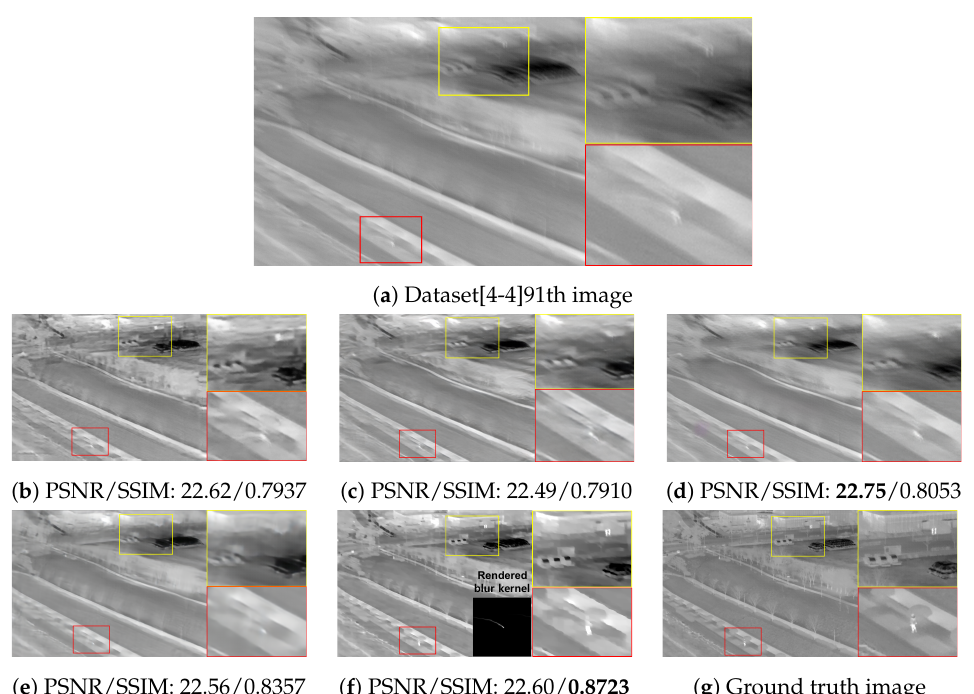
Figure 14. Qualitative comparison of deblurring results on the SBTI dataset [4-4]91th. ( a ) Synthetic blurry thermal image, ( b ) SRN [33], ( c ) SIUN [36], ( d ) DeblurGAN.v2 [35], ( e ) CDVD [34], ( f ) Ours, ( g )